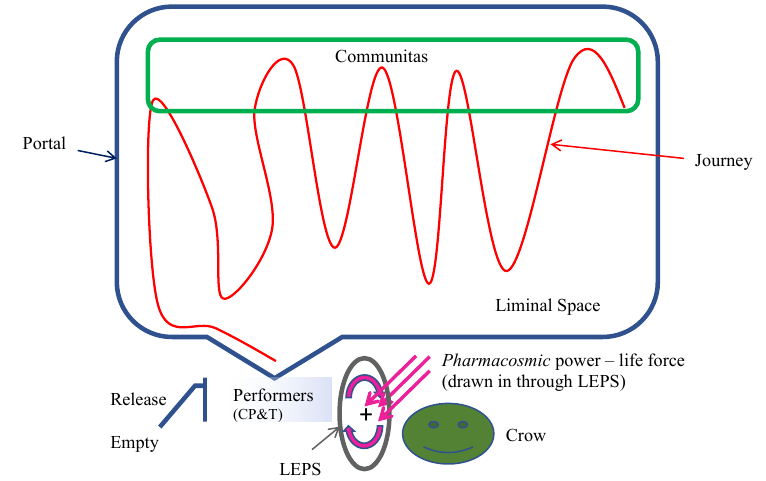
Figure 3. Live Performance Journey (AmunRave